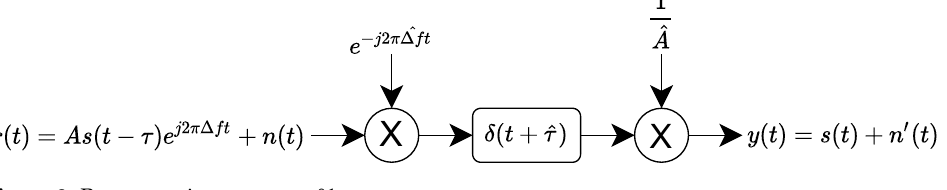
Figure 3. Preprocessing process n°1.